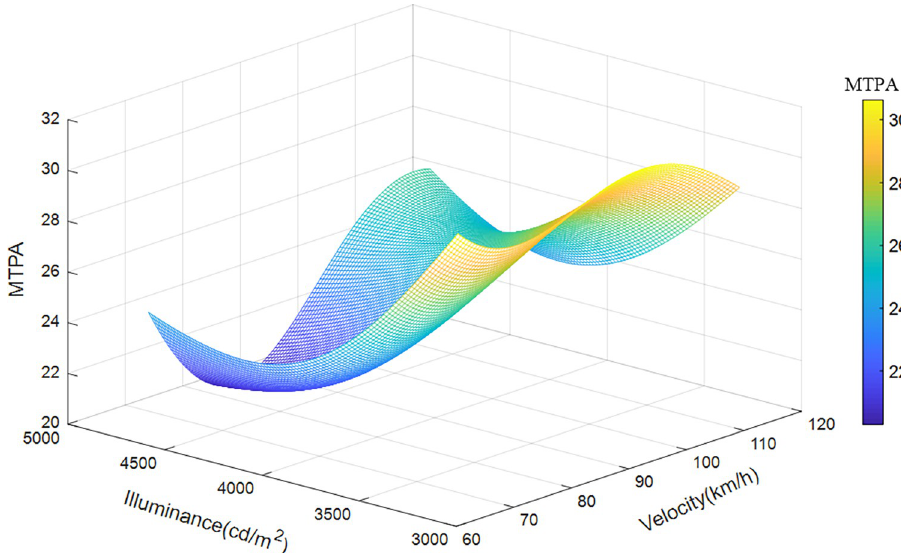
Fig 11. Variation characteristics of velocity, illuminance, and visual load in departure